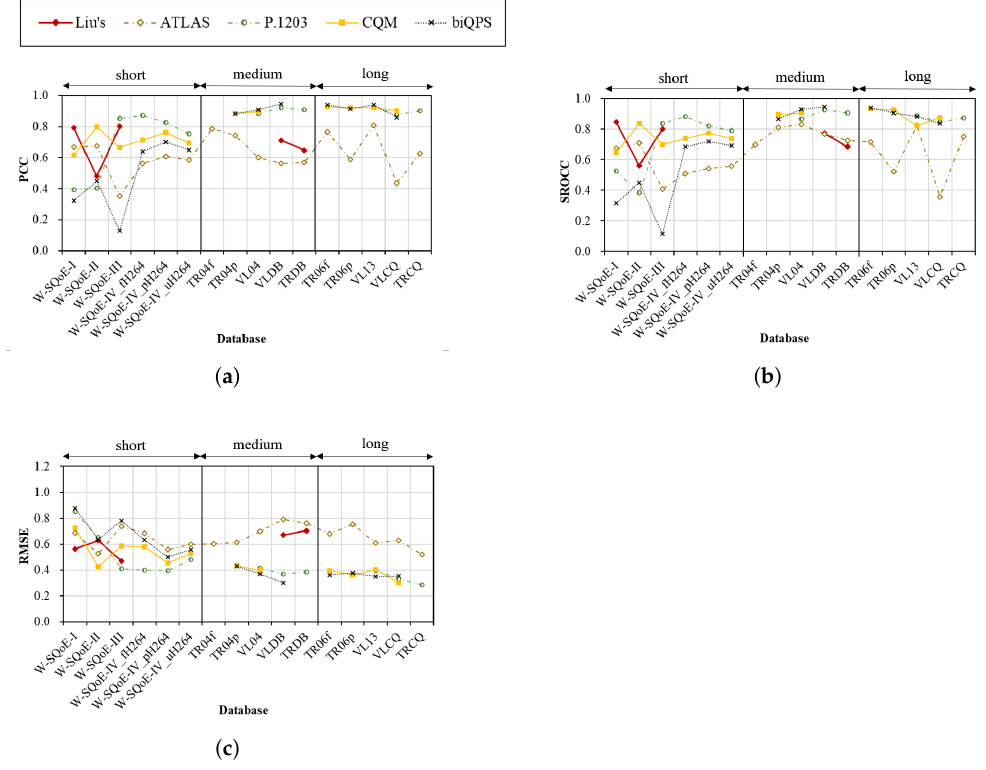
Figure 7. Performance of Liu’s , ATLAS , P.1203 , CQM , and biQPS models in the second group over the test databases. ( a ) PCC; ( b ) SROCC; ( c )